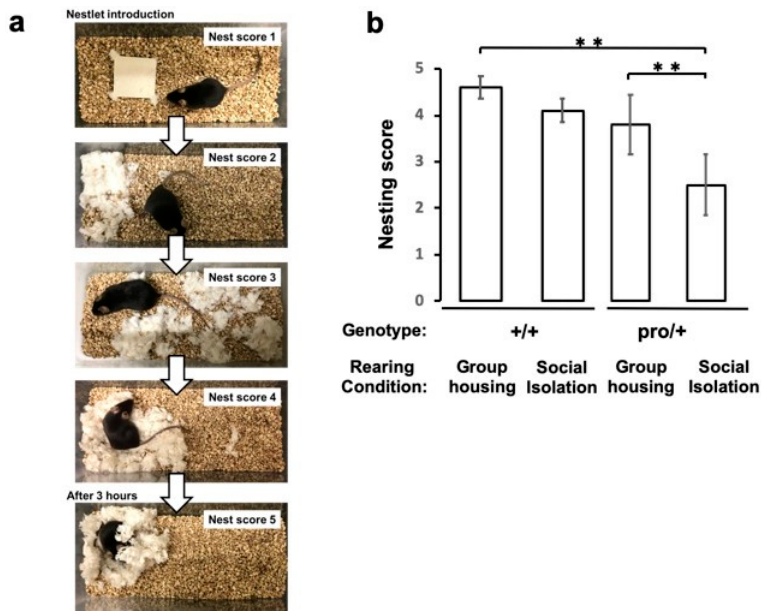
Figure 4. Deficit in nest building by socially isolated BDNF pro /+ mice. ( a ) Nest-building scoring (from 1 to 5, as described in Materials and Methods). ( b ) BDNF pro /+ and BDNF +/+ mice were housed in group or social isolation cages for 8 weeks before they were subjected to the nest-building behavioral test. Data are presented as the means ± SEMs from ten animals / group (** p < 0.001, one-way ANOVA followed by Tukey–Kramer test).